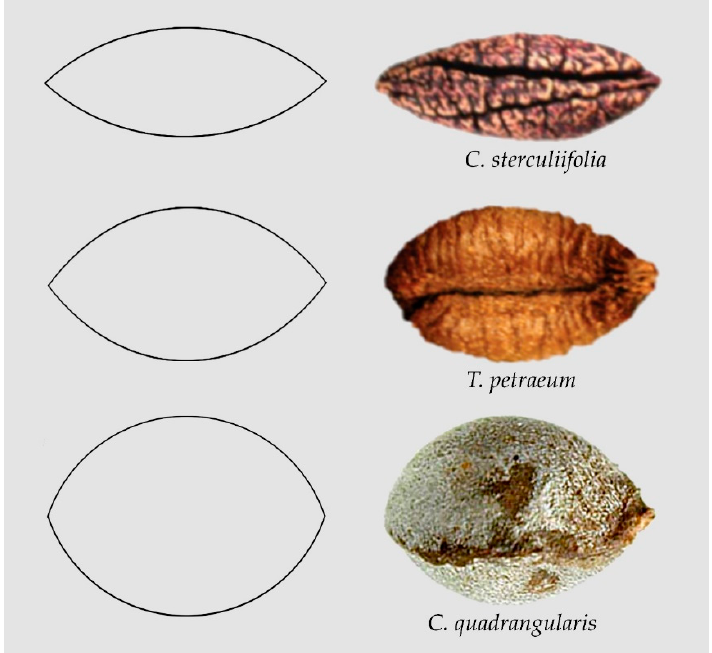
Figure 1. The images of seeds of Cissus sterculiifolia [31], Tetrastigma petraeum [51] and Cissus quadrangularis [44] resemble lenses of different proportions.